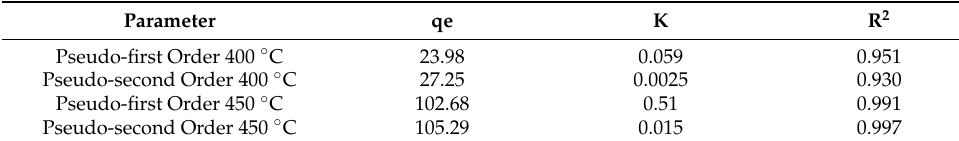
Table 7. Parameters of pseudo-first-order and pseudo-second-order kinetic models for biochar in nature.